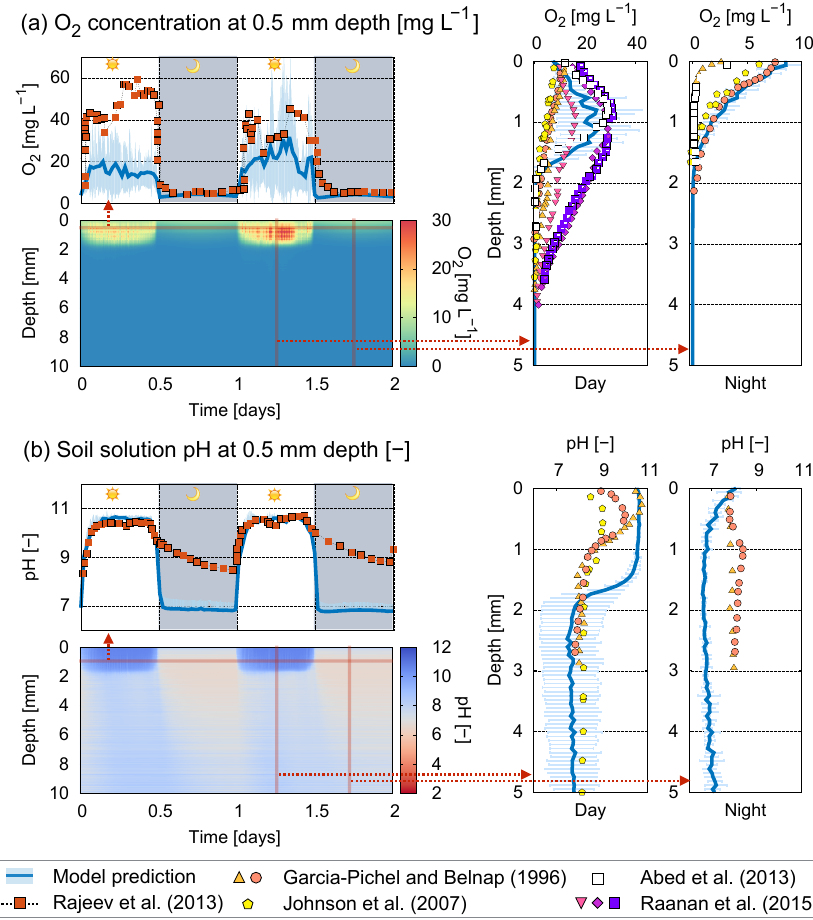
Figure 8. Oxygen and pH profiles within saturated biocrusts. Spatio-temporal dynamics of the (a) oxygen profile and (b) pH profile of modelled biocrusts (fully saturated) under diurnal cycles. The horizontal average of profiles is taken and 10 independent simulations are averaged to see the general dynamics of various biocrusts. For comparisons, 500µm of depth is chosen to represent the temporal behaviour of the top crust. Depth-averaged profiles at midday and midnight are used to compare with experimental measurements of biocrust response under light and dark